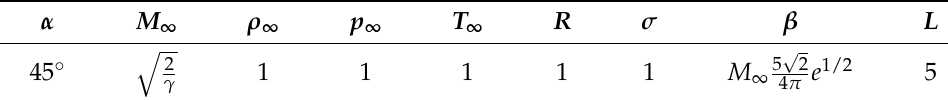
Table A1. Conditions used in analytical solution